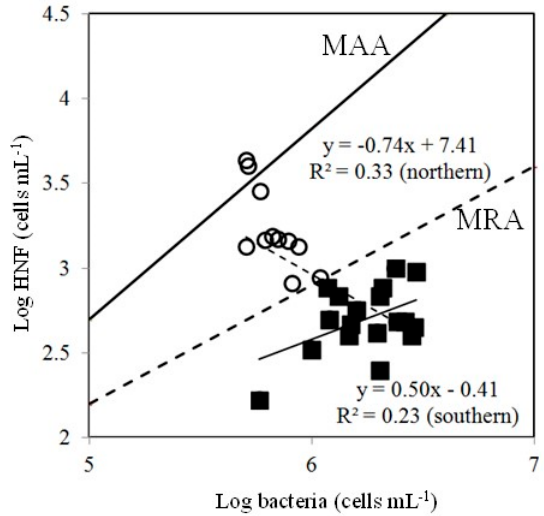
Figure 8. Simultaneous observations of bacterial and HNF abundances plotted following Gasol’s model [16]. MAA is the maximum attainable abundance line, and MRA is the mean realized abundance line. ( ○ ): the data for transects A–D; ( ■) : the data for transects E–I.